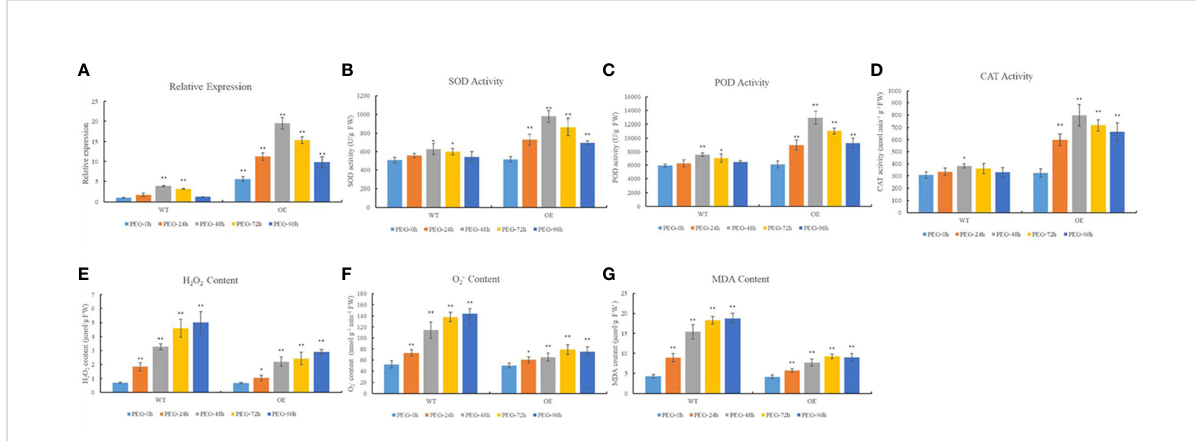
FIGURE 4 Relationship between the redox status and the expression of TaTRX24 . (A) The relative expression of TaTRX24 gene in WT and OE line before and at 24h, 48h, 72h and 96h after treatment with 20% PEG 6000. (B) The SOD activity in WT and OE line before and at 24h, 48h, 72h and 96h after treatment with 20% PEG 6000. (C) The POD activity in WT and OE line before and at 24h, 48h, 72h and 96h after treatment with 20% PEG 6000. (D) The CAT activity in WT and OE line before and at 24h, 48h, 72h and 96h after treatment with 20% PEG 6000. (E) The H 2 O 2 content in WT and OE line before and at 24h, 48h, 72h and 96h after treatment with 20% PEG 6000. (F) The O 2- content in WT and OE line before and at 24h, 48h, 72h and 96h after treatment with 20% PEG 6000. (G) The MDA content in WT and OE line before and at 24h, 48h, 72h and 96h after treatment with 20% PEG 6000. PEG-0h, PEG-24h, PEG-48h, PEG-72h and PEG-96h respectively represent that the above wheat materials were not treated with 20% PEG 6000, and were treated with 20% PEG 6000 for 24h, 48h, 72h and 96h. Values are mean ( ± SE) of three biological replicates. * P < 0.05, ** P < 0.01 represent signi fi cant difference between the WT (PEG-0h) and the others,